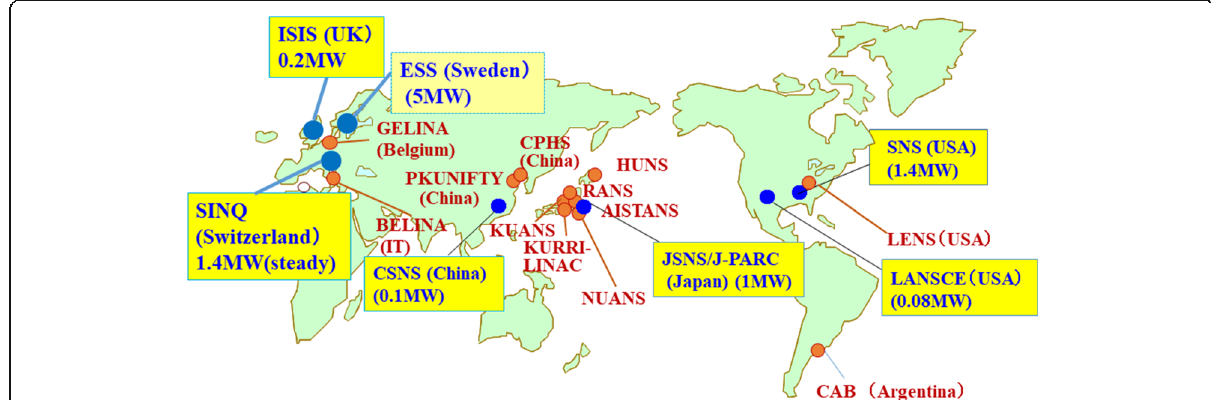
Fig. 4 Accelerator-driven neutron sources used for neutron beam experiments in the world